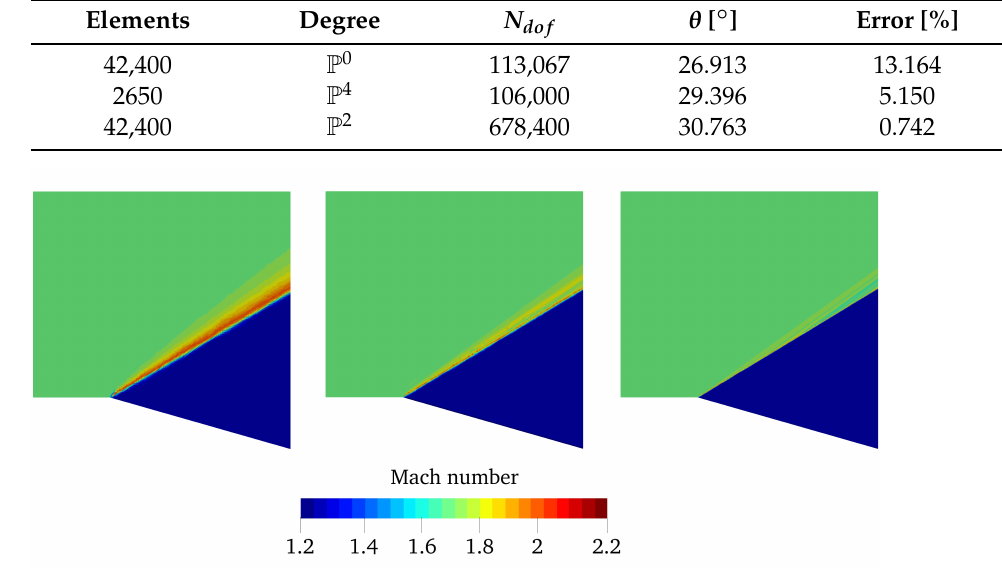
Table 4. Wedge. Angles for the rarefaction shock in the wedge-shaped channel case.